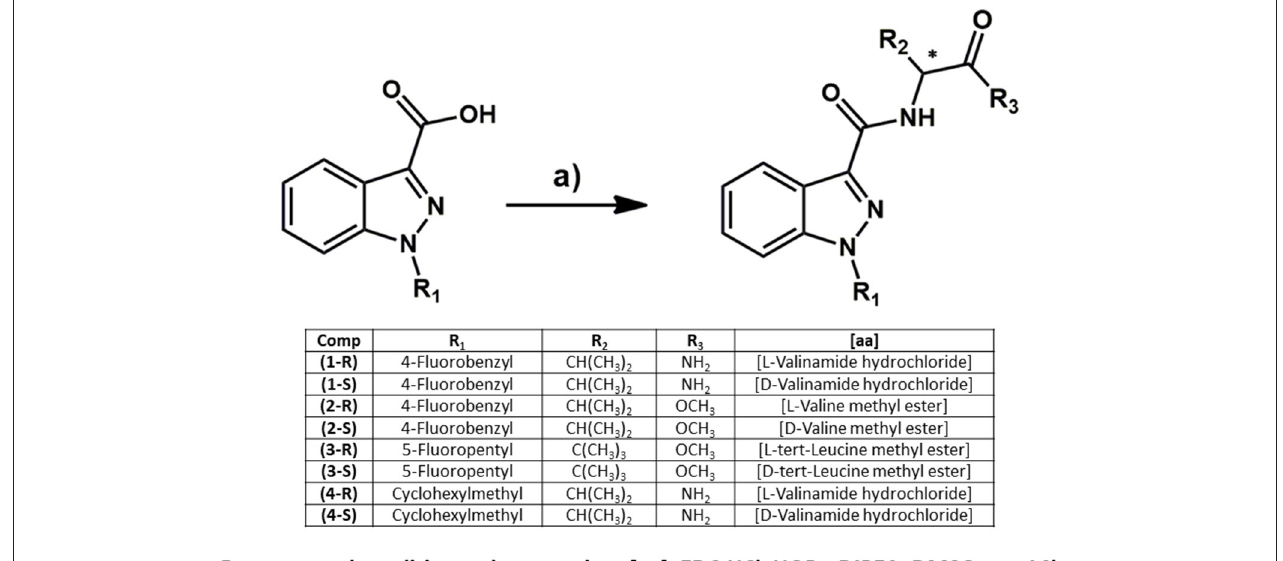
FIGURE 2 | Enantiospecific synthesis of eight indazole-3-carboxamide synthetic cannabinoids. Compound numbering relates to that provided in Figure 1 .